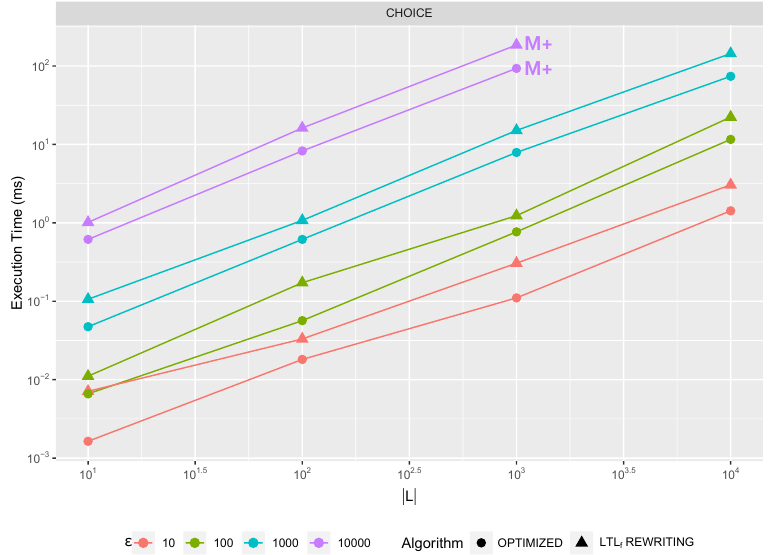
Figure 8. Results for the custom declarative clause implementations Section 6.2 against the traditional logical